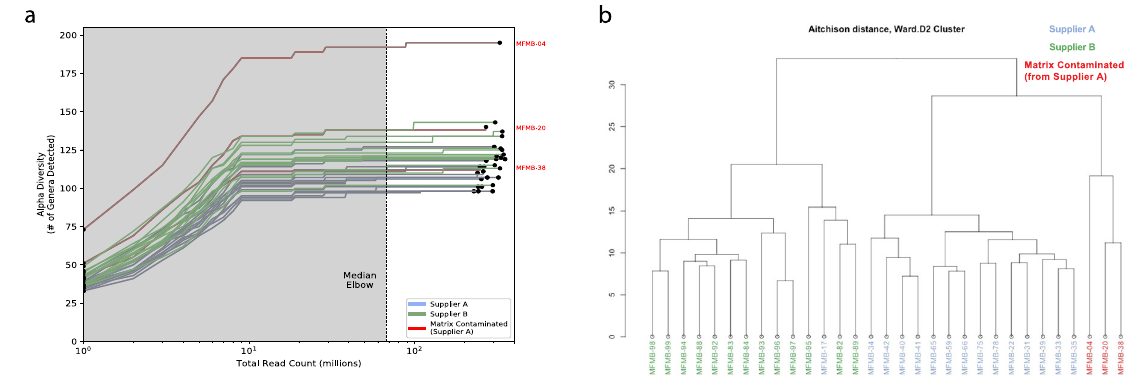
Fig. 2 Ecological metrics of microbiome community. a Alpha diversity (number of genera) for all ( n = 31) high protein powder metatranscriptomes is compared to the total number of sequenced reads for a range of in silico subsampled sequencing depths. The dashed vertical line indicates the medial elbow (at ~ 67 million reads). b Hierarchical clustering of Aitchison distance values of poultry meal samples based on microbial composition. Samples were received from Supplier A (blue and red) and Supplier B (green). Matrix-contaminated samples are additionally marked in